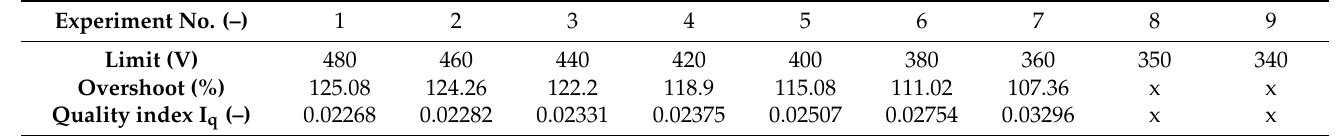
Table 7. Parameters values of control system with voltage limits for one-input actuator.